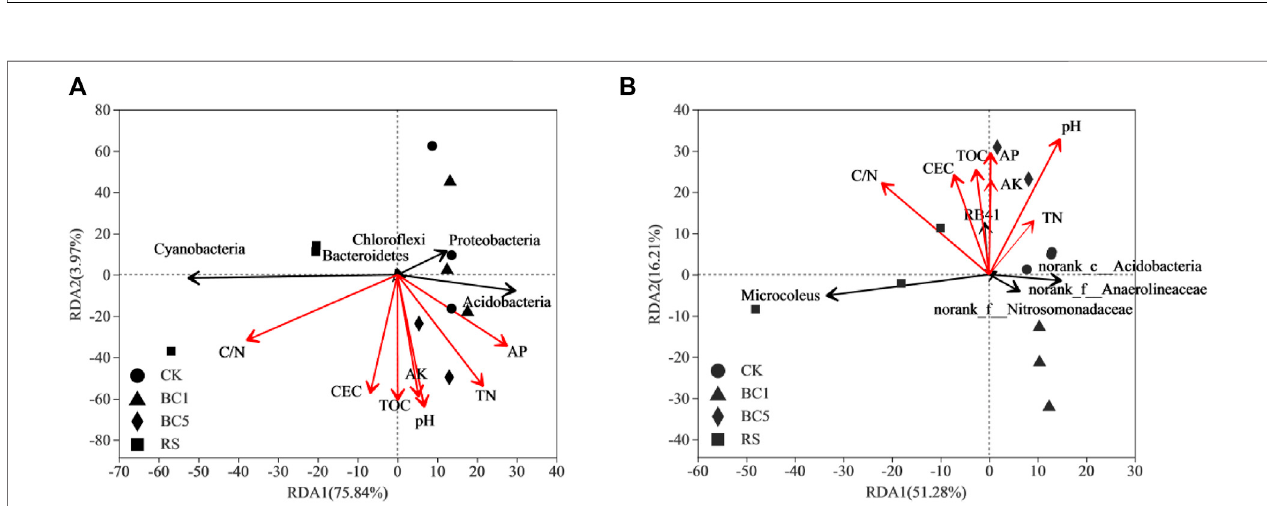
FIGURE7| Redundancyanalysis(RDA)oftherelationshipbetweentherelativeabundanceofsoilbacterialphyla (A) andgenera (B) andenvironmentalfactors.CK: without biochar or rice straw; BC1: 2.25 Mgha − 1 biochar; BC5: 11.25 Mgha − 1 biochar; RS: 2.25 Mgha − 1 rice straw. TN, total nitrogen; CEC, cation exchange capacity; TOC, total organic carbon; AK, available potassium; AP, available phosphorus.